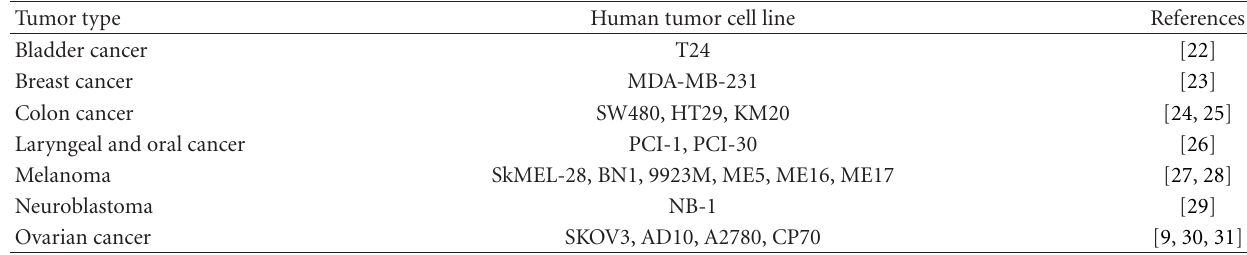
Table 2: Human tumor cell lines that express TLR4.